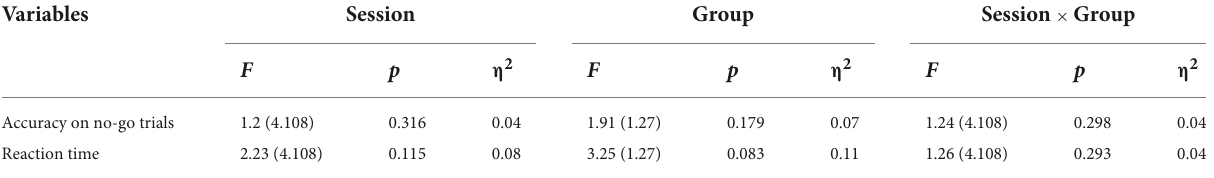
TABLE 5 Behavioral results for Go/Nogo